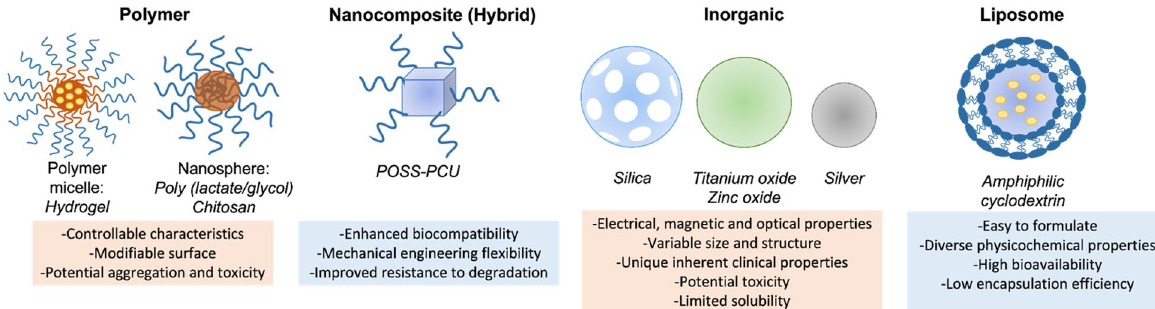
Fig. 2 Different classes of nanoparticles used in PRS. Figure created in Microsoft